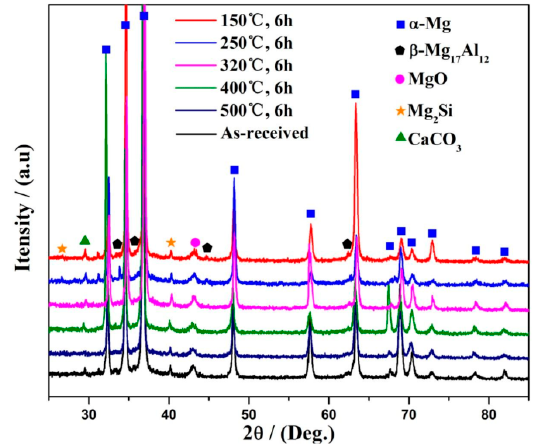
Figure 2. Phase compositions of AZ31B magnesium composite foams with CMs.